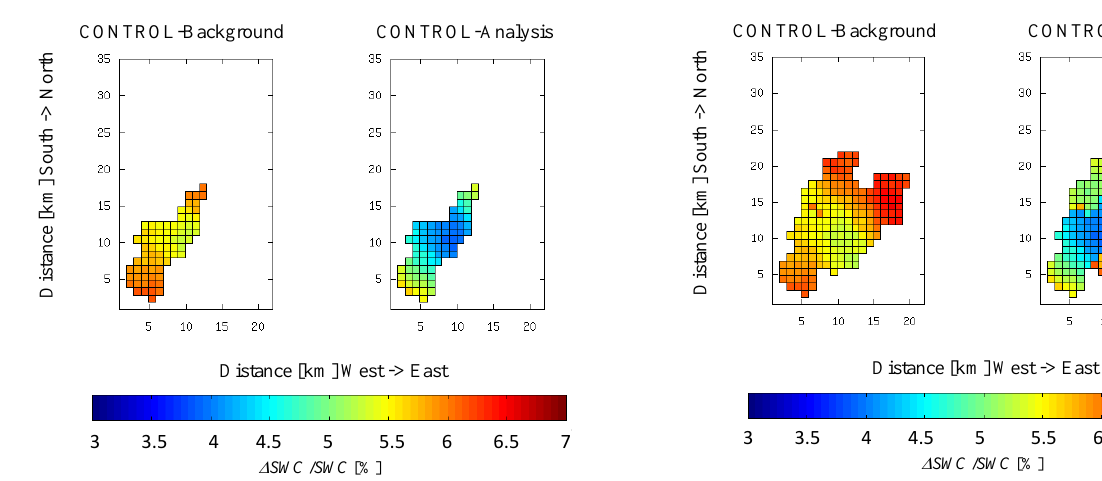
Fig. 14. The difference in soil-water content (SWC) of each grid cell relative to the CONTROL SWC of each grid cell for the ini- tial time t =0 (5 May 1997) for the background and analysis. The analysis was obtained assimilating streamflow from the CONTROL model simulation from Große Enz outlet from t =0 to t =34h with a 0.5 hourly timestep.